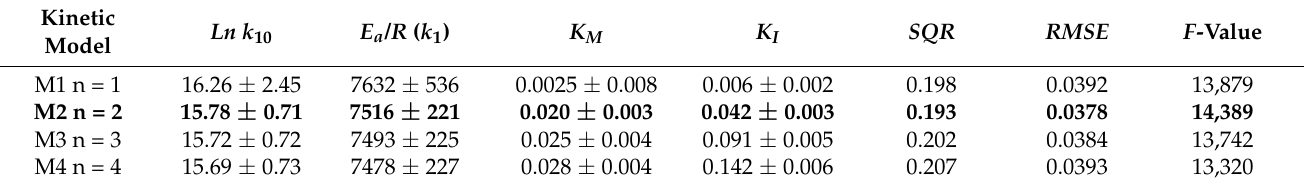
Table 3. Kinetic constants (with their standard errors) and goodness-of-fit statistical parameters for the kinetic model fitted to all data from cellobiose hydrolysis runs performed at several temperatures and initial substrate concentrations. The selected model is in bold